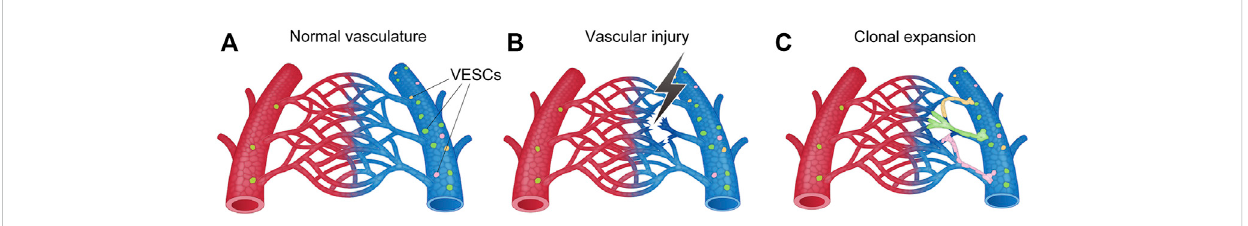
FIGURE 7 Schematicillustrationofangiogenesis(i.e.,newblood-vesselformation)fromvascularendothelialstemcells(VESCs)byclonalexpansion. (A) VESCs reside within the intima of the blood vessel. Mouse VESCs strongly express CD157 (Bst1), Myc, ATF3, Fosl2, Sox7, Foxp1, ABCB1a, and ABCG2. (B) Angiogenic stimuli activates VESCs following vascular injury, ischemia, and in fl ammation. (C) New sprouting occurs from nearby VESCs to form new blood